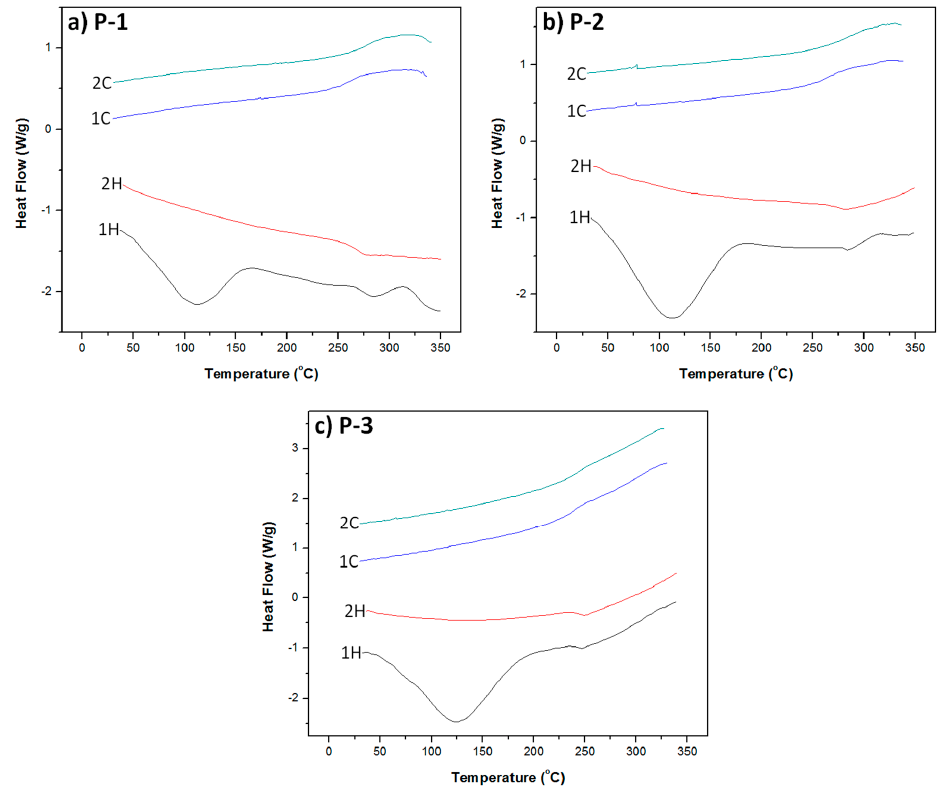
Figure 5. Differential scanning calorimetry (DSC) thermograms of ionic polymers P-1, P-2, and P-3 Figure 5. Di ff erential scanning calorimetry (DSC) thermograms of ionic polymers ( a ) P-1 , ( b ) P-2 , and ( c ) obtained at heating and cooling rates of 10 °C/min in nitrogen. P-3 obtained at heating and cooling rates of 10 ◦ C / min in